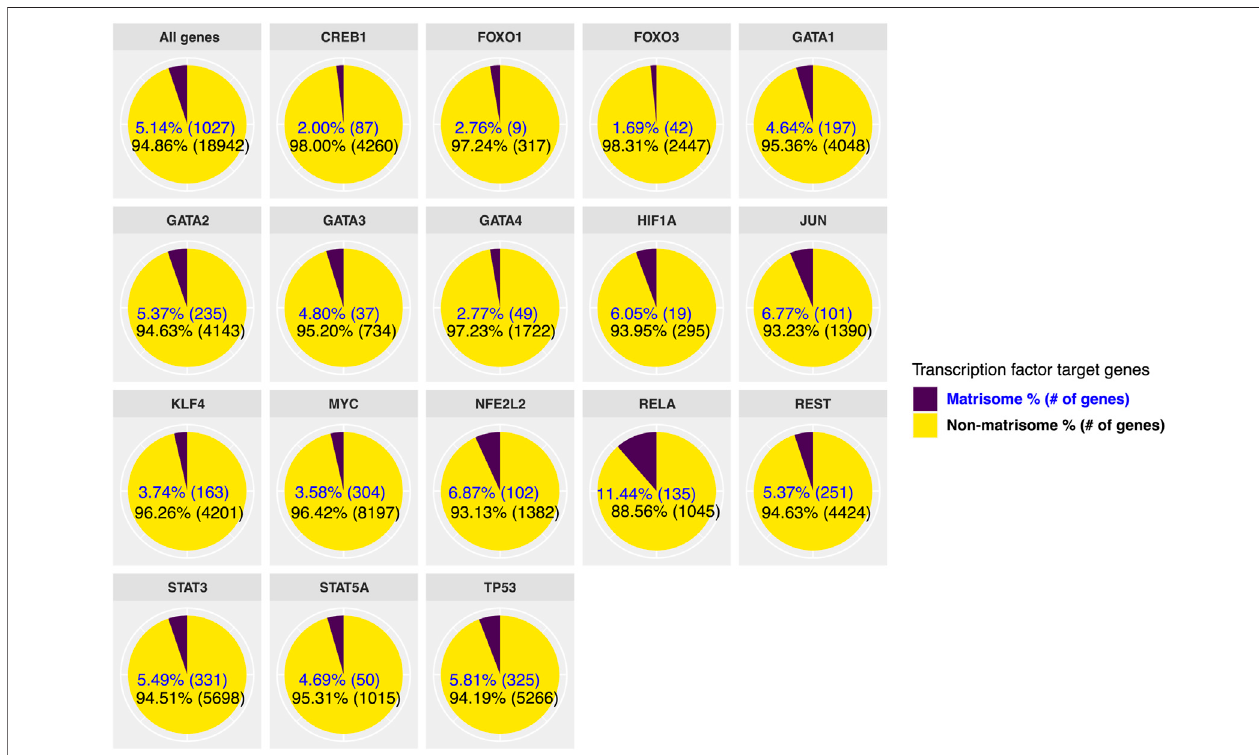
FIGURE 2 | Direct regulation of matrisome genes by longevity transcription factors. We used previously published ChIP-seq studies to fi nd target genes of transcriptionfactorsthatareassociatedwithlongevity.Wedividedthetargetgenesofeachtranscriptionfactorintomatrisomeandnon-matrisomegenes.Fromselected longevity transcription factors, MYC regulates the highest number of overall genes, while the largest number of matrisome genes is regulated by STAT3.